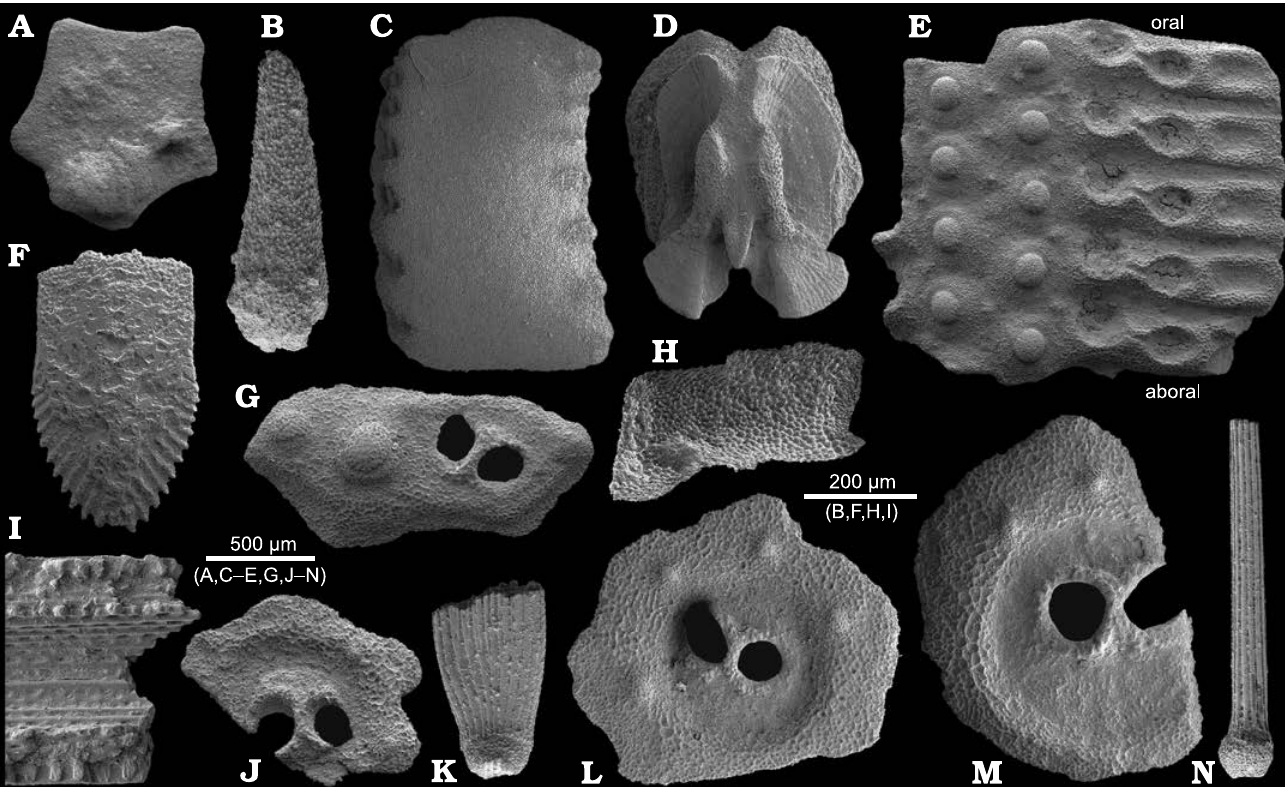
Fig. 30. Echinoderm plates, ossicles, and elements from Misurina Landslide, northern Italy, Cassian Formation; Carnian, Upper Triassic. A . PZO 12765, isocrinid? (sediment encrusted) columnal. B . PZO 12878, asteroid?/asterozoan spine. C , D , H . Ophiuroids. C . PZO 12879, lateral arm plate, external view, showing the articulation for the attachment of spines. D . PZO 12880, arm vertebra, distal view, showing the muscle attachment area. E . PZO 12885, part of ambulacrum of unknown cidaroid? species. H . PZO 12881, distal lateral arm plate, in external view. F . PZO 11827, ophiocistioid goniodont Linguaserra triassica Reich in Reich et al., 2018, abaxial face, in outer view. G . Pronechinus ? sp., PZO 12777, ambulacral plate. I . PZO 12884, broken hollow cidaroid? spine fragment, showing the microstructure at the inner side of the cylinder. J , L , M . Ambulacral plates of Pronechinus ? sp. with slightly developed peripodial rim surrounding pore pairs ( J , PZO 12780; L , PZO 12778; M , PZO 12779). K , N . Cidaroid? spines (partially broken) of unknown species ( K , PZO 12882; N , PZO